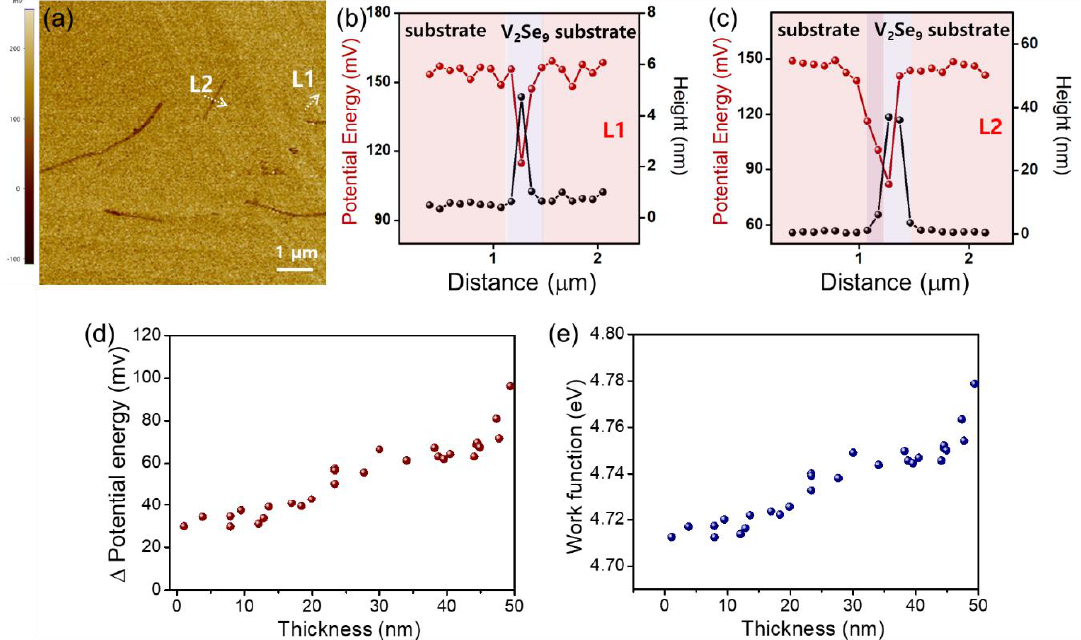
Figure 5. ( a ) Scanning Kelvin probe microscopy (SKPM) image of exfoliated 1D V 2 Se 9 flakes on the Si substrate. ( b , c ) Height and potential energy profiles of the V 2 Se 9 flakes and Si substrate as labeled in Figure 5a. ( d , e ) Variation in potential energy difference and work function depending as a function of thickness of V 2 Se 9 flakes.